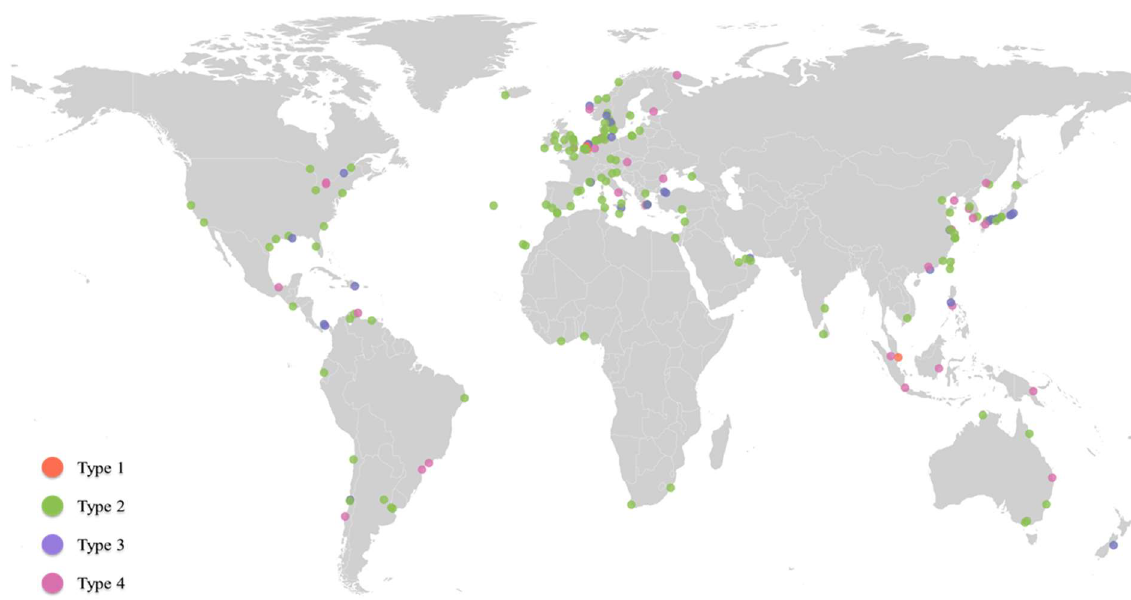
Figure 3. Geographical distribution of different types of ports.